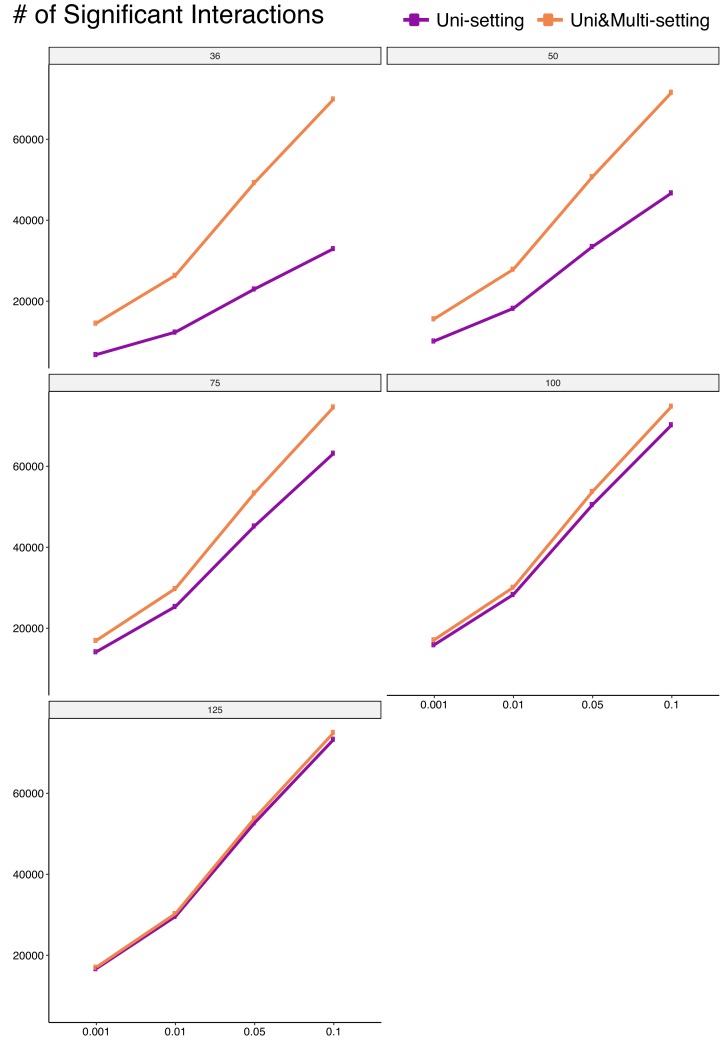
Numbers of significant interactions identified with trimmed reads under Uni- and Uni&Multi-settings at FDR 0.1%, 1%, 5%, 10%.